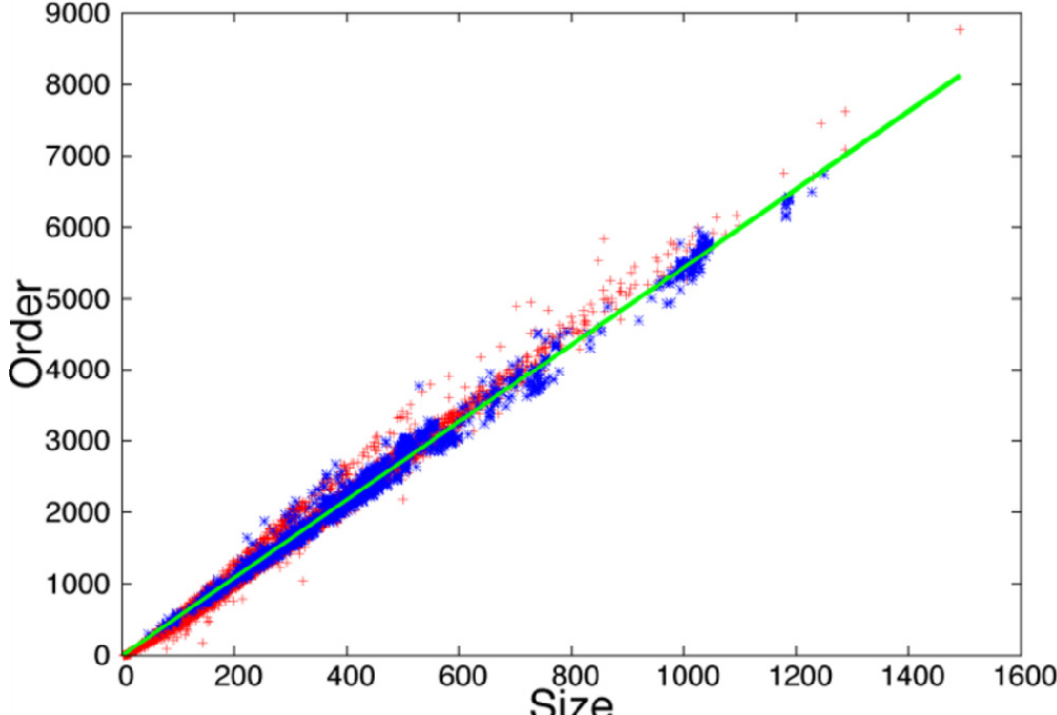
Figure 3. Density of residue contacts for globular and transmembrane proteins. Protein structures were transformed into contact maps at 5 Å to obtain the number of residues (Size) and the total number of reside contacts (Order) for each protein analyzed (see Methods). Size and Order are plotted for both globular (+) and transmembrane (+) proteins. The green line represents the best linear adjustment to both data sets and has a slope of 5.4. The plot was generated using gnuplot. In an attempt to identify local differences in packing between these classes of pro- teins, we looked for maximal cliques in their residue contact maps. Maximal cliques are those cliques (group of residues that are all in contact in the 3D space) that are not part of any larger clique, hence correspond with the densest regions within proteins. We ob- served that TM proteins accumulated small maximal cliques (size 3) more than globular proteins (see Figure 4). Thus, the set of TM proteins analyzed are less densely packed than the globular proteins as a consequence of reducing the number of large maximal cliques.